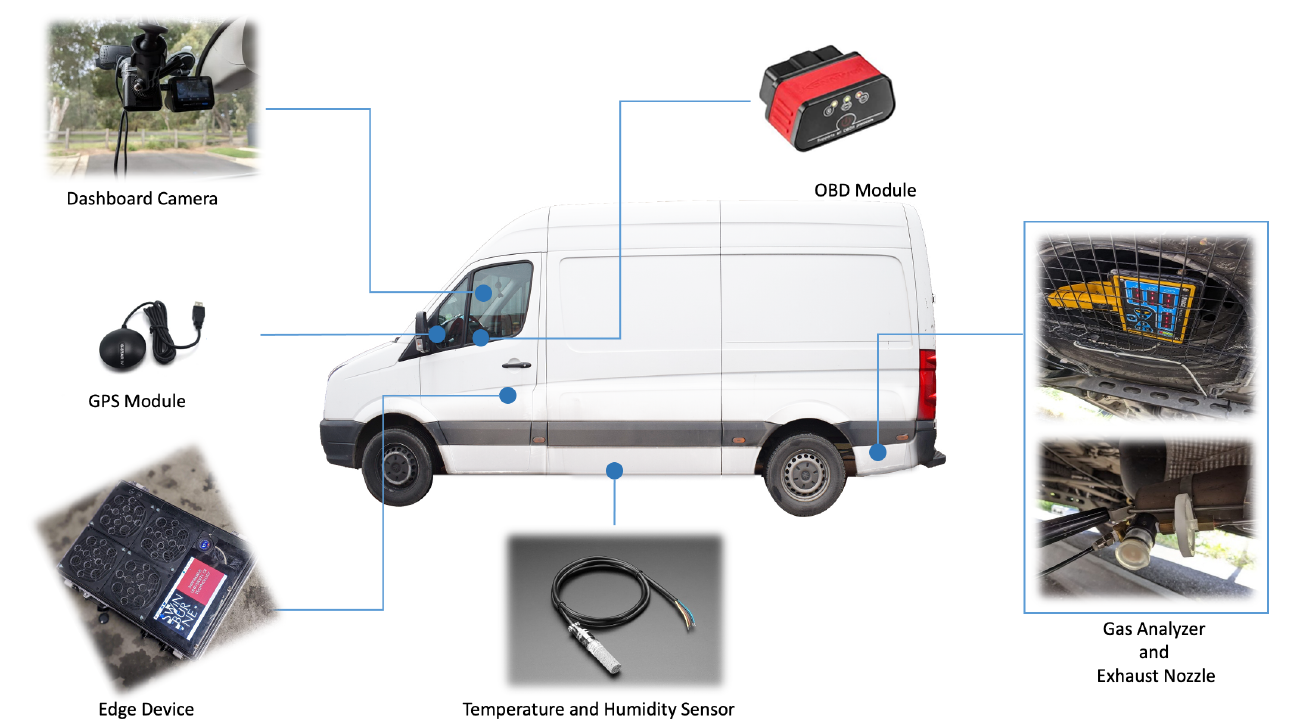
Figure 3. ParcEMon platform